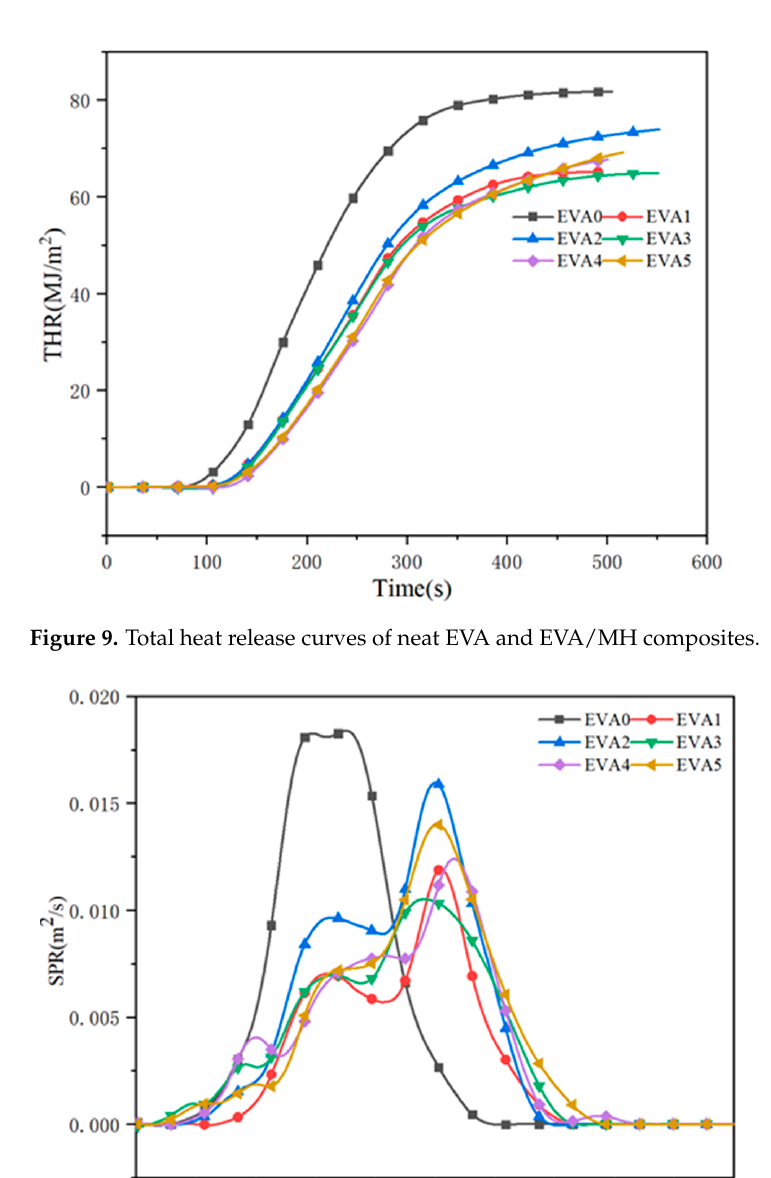
Fire resistance can also be evaluated from the residues present after the combustion of